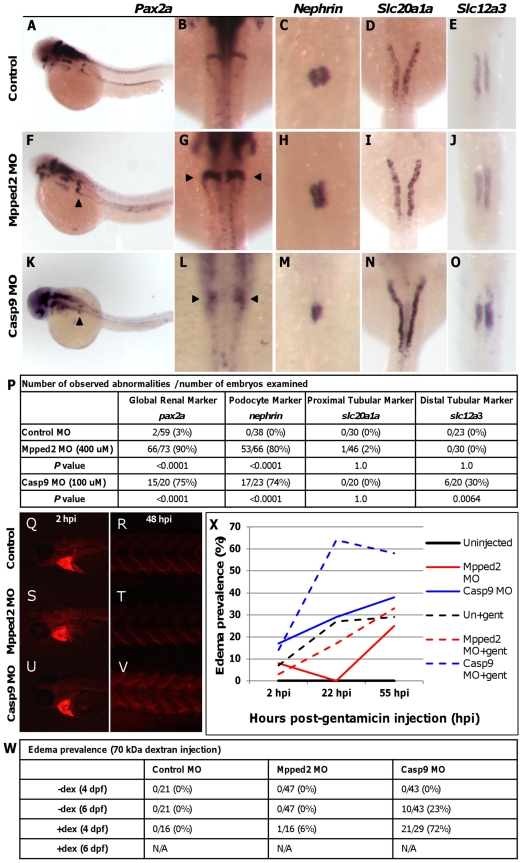

Mpped2 and casp9 knockdowns result in defective kidney development.(A–E) Whole mount in situ hybridization in control embryos demonstrates normal expression of the global kidney marker pax2a (A: lateral view; B: dorsal view), the glomerular marker nephrin (C), and the tubular markers slc20a1a (proximal tubule, D), and slc12a3 (distal tubule, E) at 48 hours post fertilization (hpf). (F–J) Mpped2 morpholino (MO) knockdown embryos develop glomerular gene expression defects (F–H, arrowheads), but tubular marker expression is normal (I, J). (K–O) Casp9 MO knockdown embryos demonstrate reduced glomerular gene expression (K–M, arrowheads) and shortened distal tubules (O). (P) Quantification of observed abnormalities per number of embryos reveal significant differences in expression of pax2a and nephrin in response to knockdown of both mpped2 and casp9 (Fisher's exact test). (Q–V) Embryos were injected with control, mpped2, or casp9 MO at the one-cell stage and subsequently injected with 70,000 MW fluorescent rhodamine dextran at 80 hpf. Dextran fluorescence was monitored over the next 48 hours. All dextran-injected embryos show equal loading into the cardiac sinus venosus at 2 hours post-injection (2 hpi/82 hpf; Q, S, U). Compared to control MO-injected embryos (R) and mpped2 knockdown embryos (T), knockdown of casp9 resulted in reduced dextran clearance at 48 hpi as shown by increased trunk fluorescence (V). (W) Casp9 knockdown results in increased susceptibility to edema formation both spontaneously (−dex) (P value = 0.0234, Fisher's exact test) and after dextran challenge (+dex) (P value<0.0001). Embryos injected with both MO and dextran did not survive to 6 dpf (N/A). (X) Edema develops earlier and with higher frequency in casp9 morphants following injection of the nephrotoxin gentamicin.